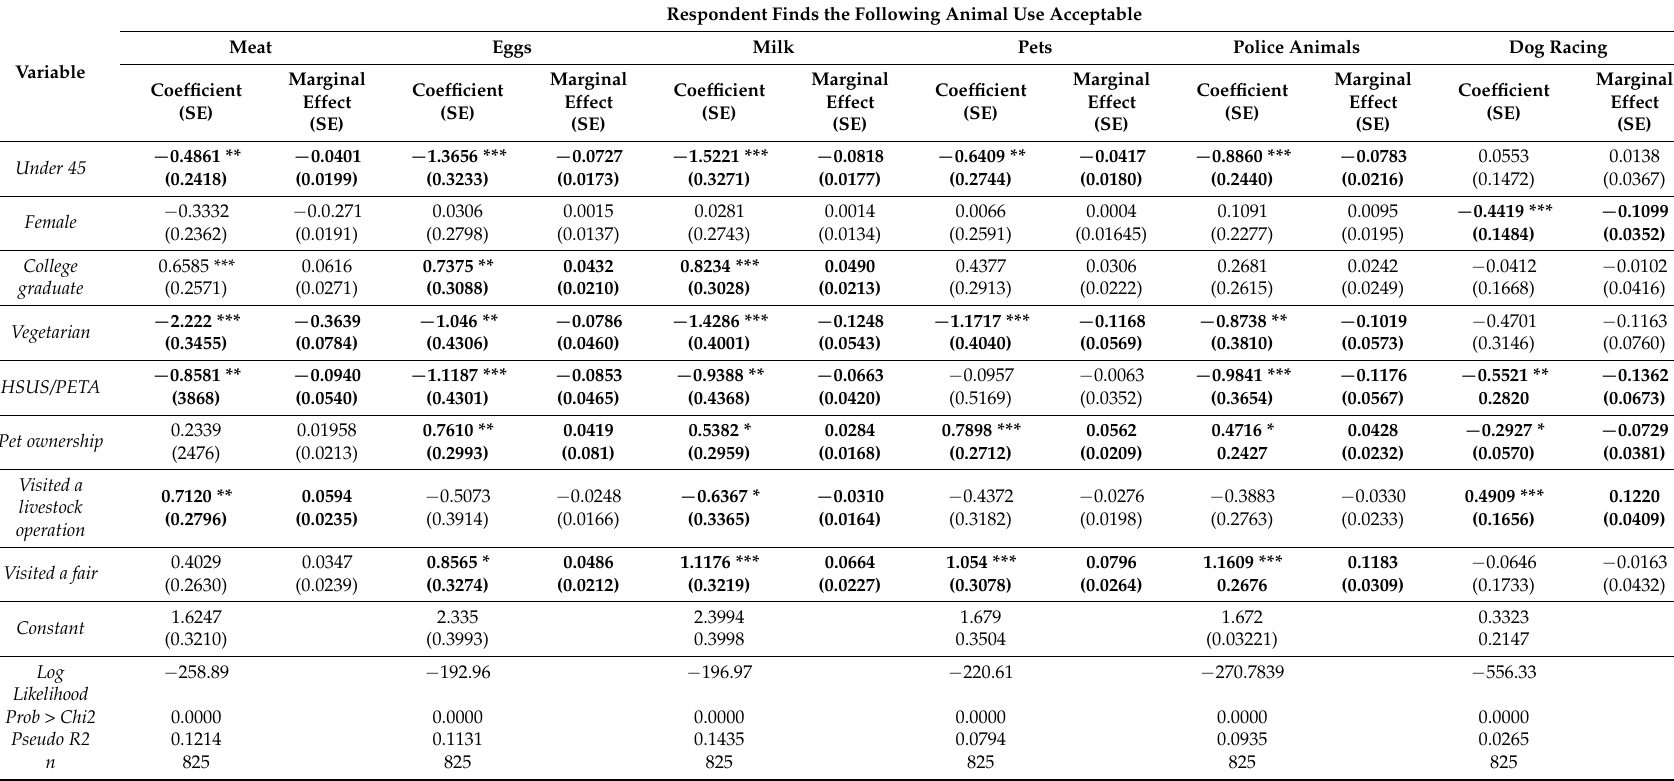
Table 5. Summary of logistic regression analysis for variables predicting finding an animal use